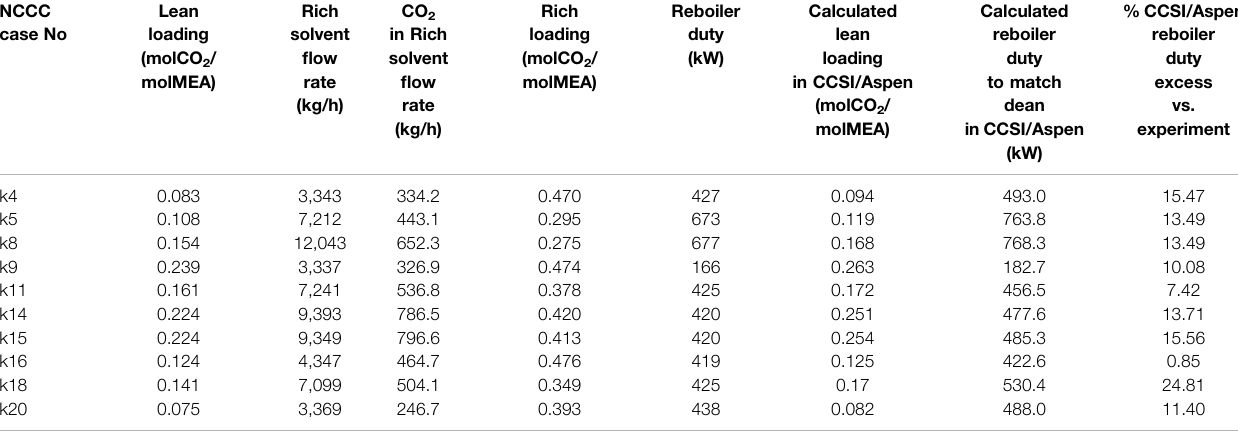
TABLE 2 | Comparison of reboiler duties between NCCC experimental data and CCSI/Aspen V10 predictions for low lean loadings. NCCC case No